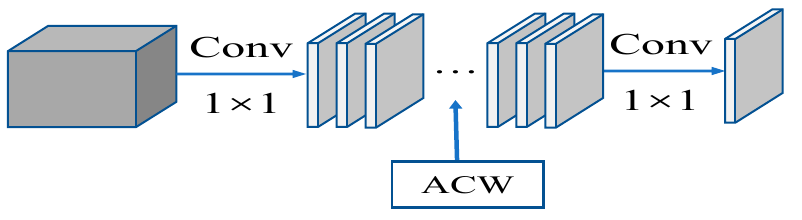
Figure 5. AuxBranch overall structure.